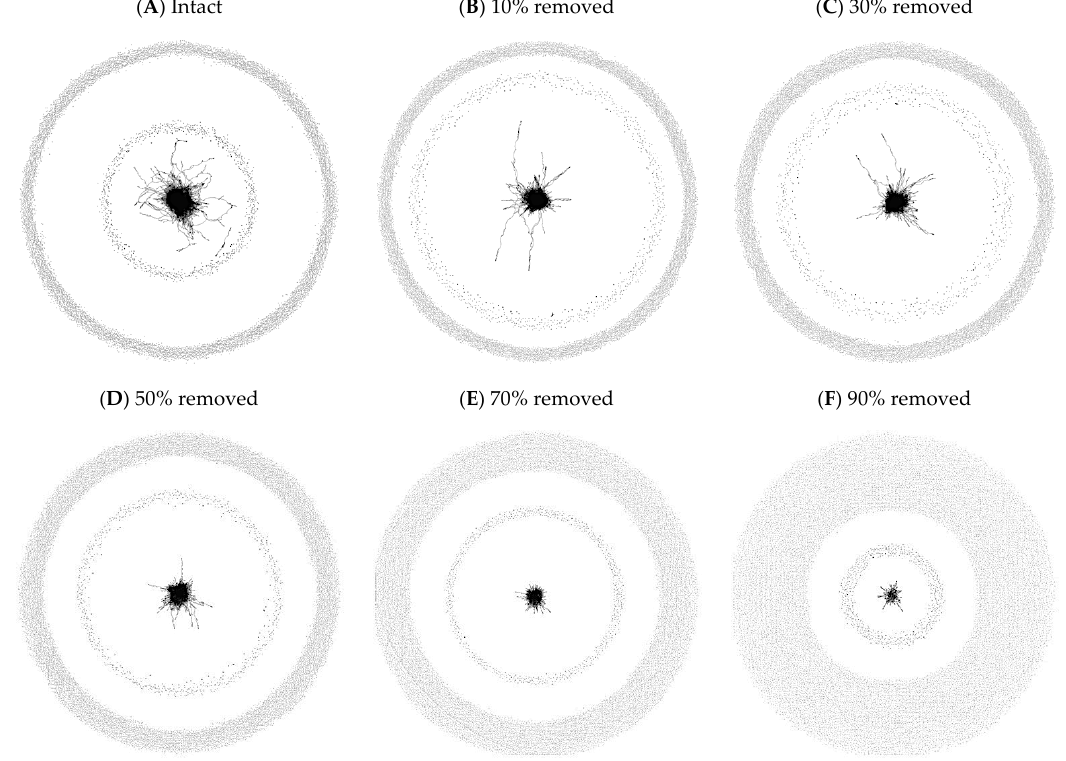
Figure 2. Panel ( A ) shows the intact network. Panels ( B – F ) show the damaged phonological networks. Each network contained the same 19,340 words (i.e., nodes), but increasing percentages of connections between words were randomly removed. The giant component is shown in the center of each network. The inner ring contains the smaller components (sometimes called “lexical islands”), and the outer ring contains the isolates (sometimes called “lexical